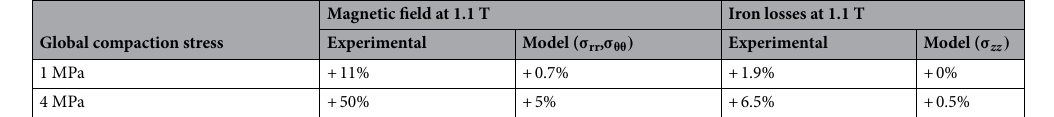
Table 6. Effect of the heterogeneous compaction on the magnetic field and iron losses at 1.1 T. Configuration with swapped input stresses in the material models.